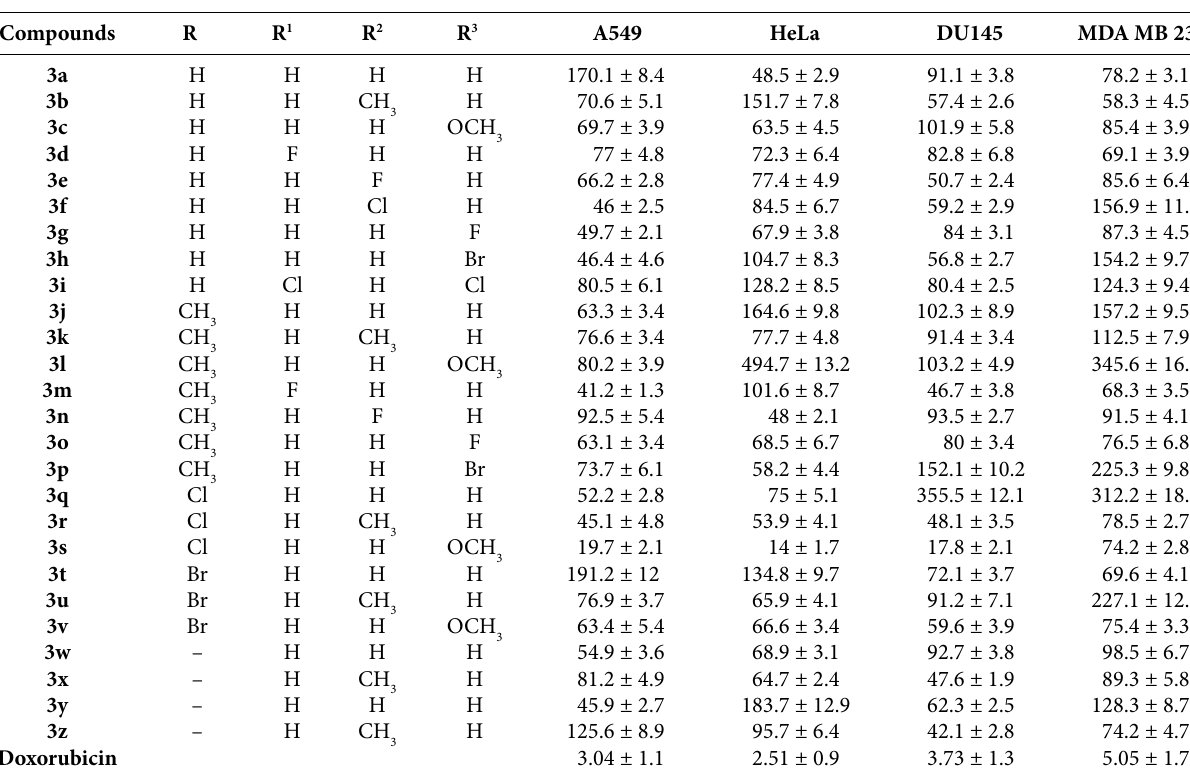
Table 1 . Anti-proliferative activity of hydrazones* Compounds